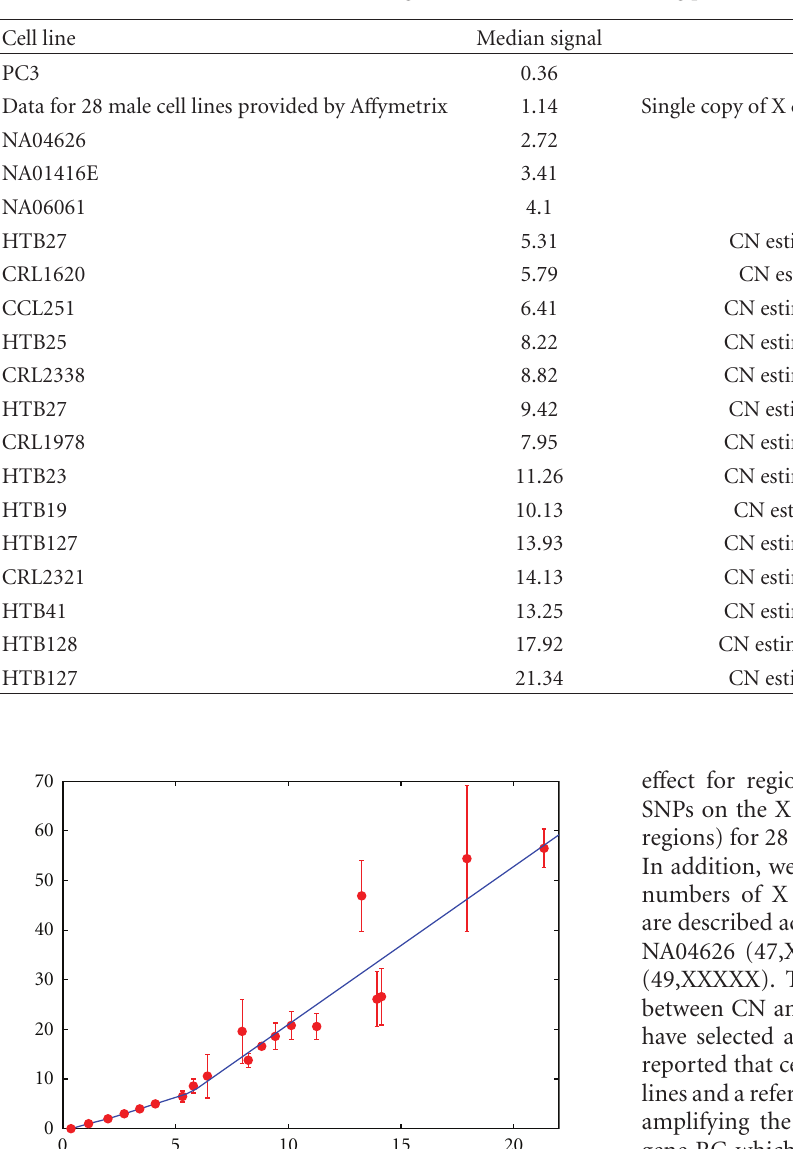
Table 1: Median signal intensities calculated using parameters generated in this paper.